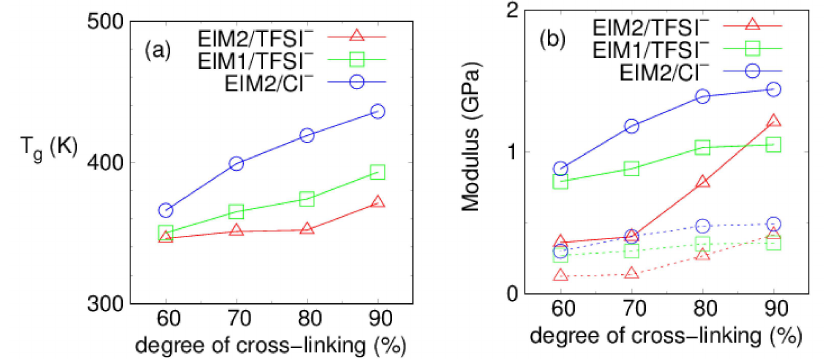
Figure 7. Glass transition temperature ( a ) T g and ( b ) elastic moduli, obtained at 300 K. Young’s and shear moduli are displayed in solid and dotted lines, respectively. Error bars are within symbol